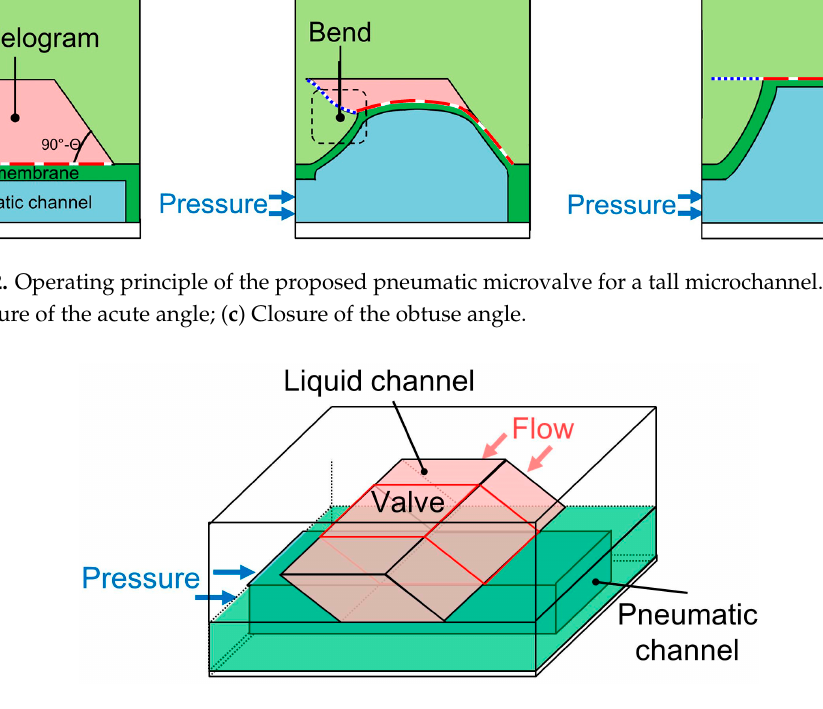
Figure 3. Constitution of the proposed pneumatic microvalve for a tall microchannel.